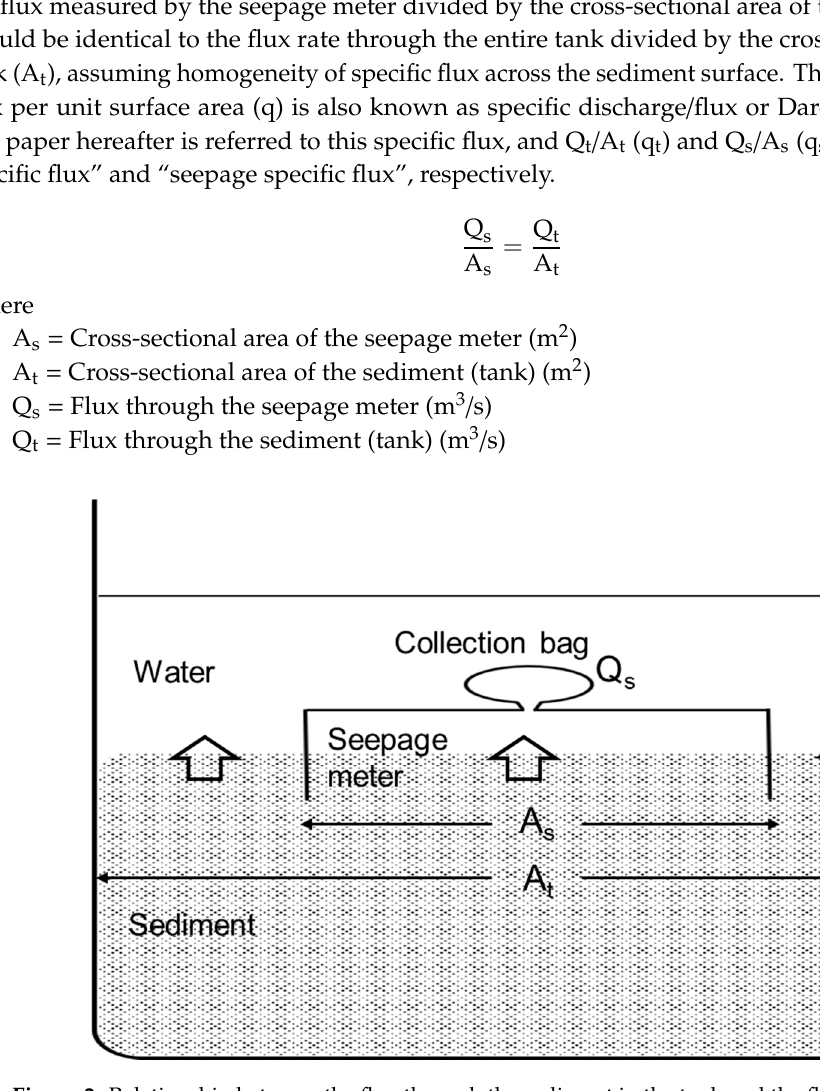
Figure 2. Relationship between the flux through the sediment in the tank and the flux measured by seepage the seepage meter.